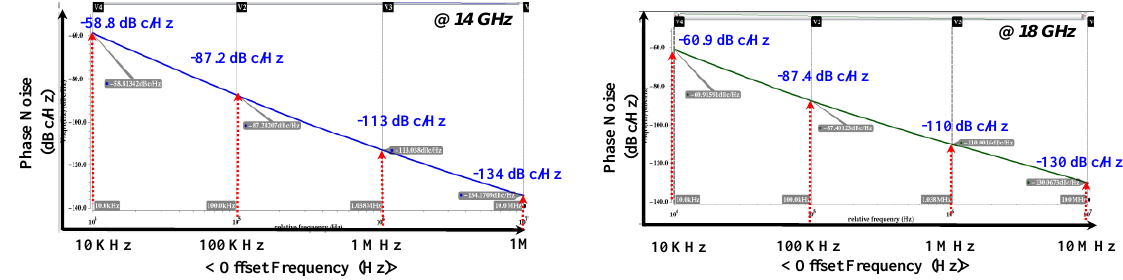
Figure 11. Phase noise performance of the VCO at 14 GHz and 18 GHz carrier frequencies.